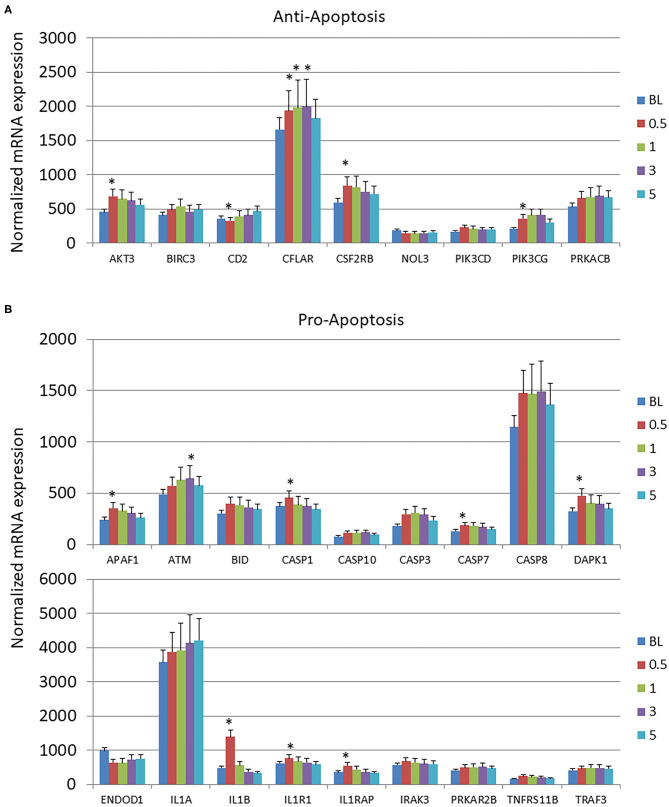
Expression levels of (A) anti-apoptotic and (B) pro-apoptotic genes in gingival samples at baseline (BL) and 0.5, 1, and 3 months following ligation. Five month samples represent 60 days following removal of the ligatures with resolution of the clinical features of the disease. The bars denote the means of 18 animal samples and the vertical bracket signifies one SD. The asterisk (*) denotes significantly different from baseline levels at p < 0.05.